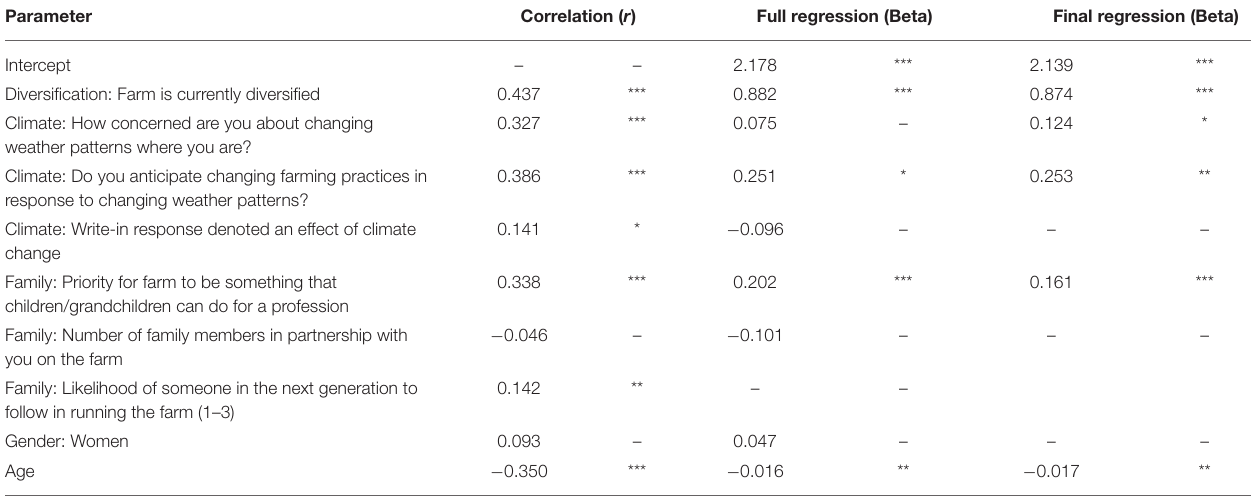
TABLE 6 | Research question 3: Outlooks on diversifying: Correlated variables, coefficients, and levels of statistical significance ( n = 179). Parameter